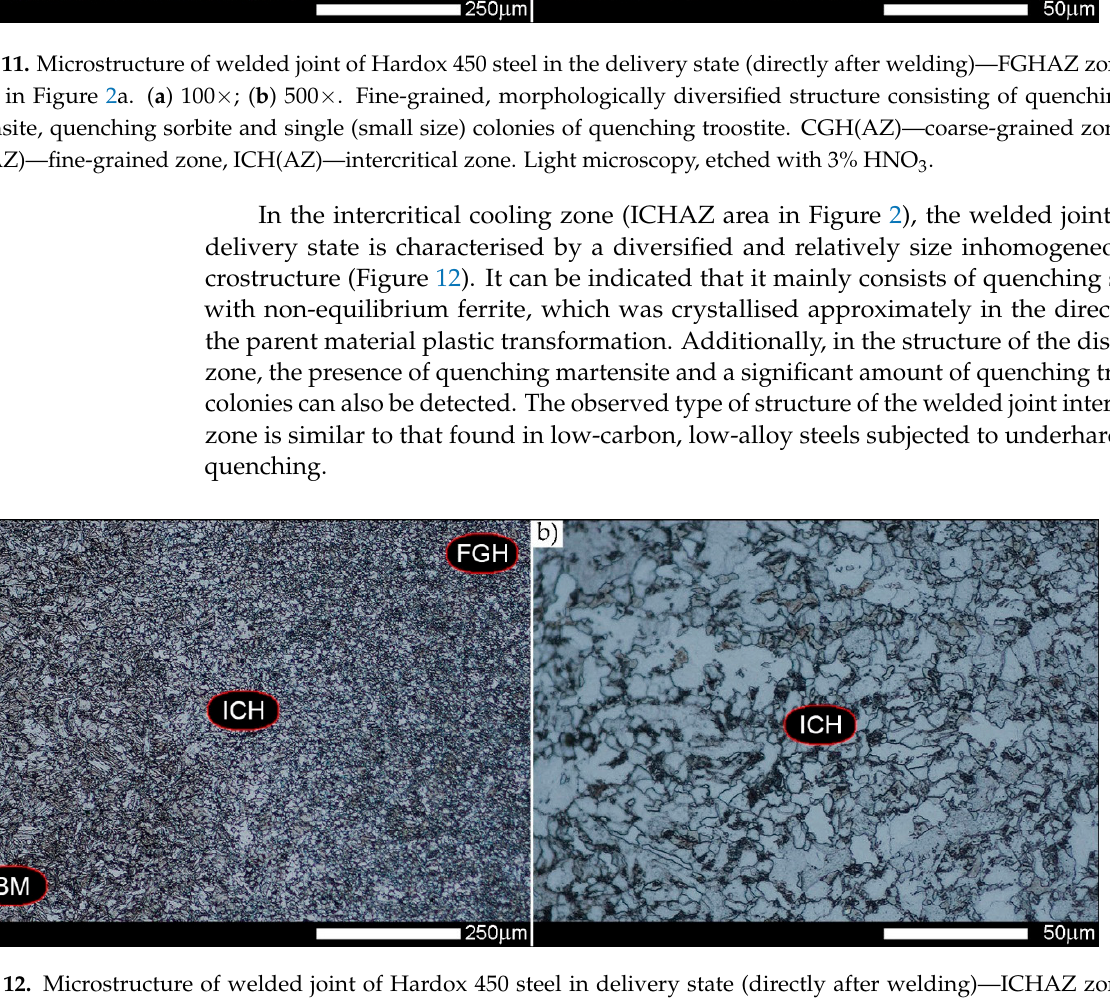
Figure 12. Microstructure of welded joint of Hardox 450 steel in delivery state (directly after welding)—ICHAZ zone shown in Figure 2a. ( a ) 100×; ( b ) 500×. Structurally diverse structure consisting of non-equilibrium grains of ferrite with quenching sorbite and martensite and quenching troostite. BM—parent material zone, FGH(AZ)—fine grain zone, ICH(AZ)—intercritical zone. Light microscopy, etched with 3% HNO 3 .